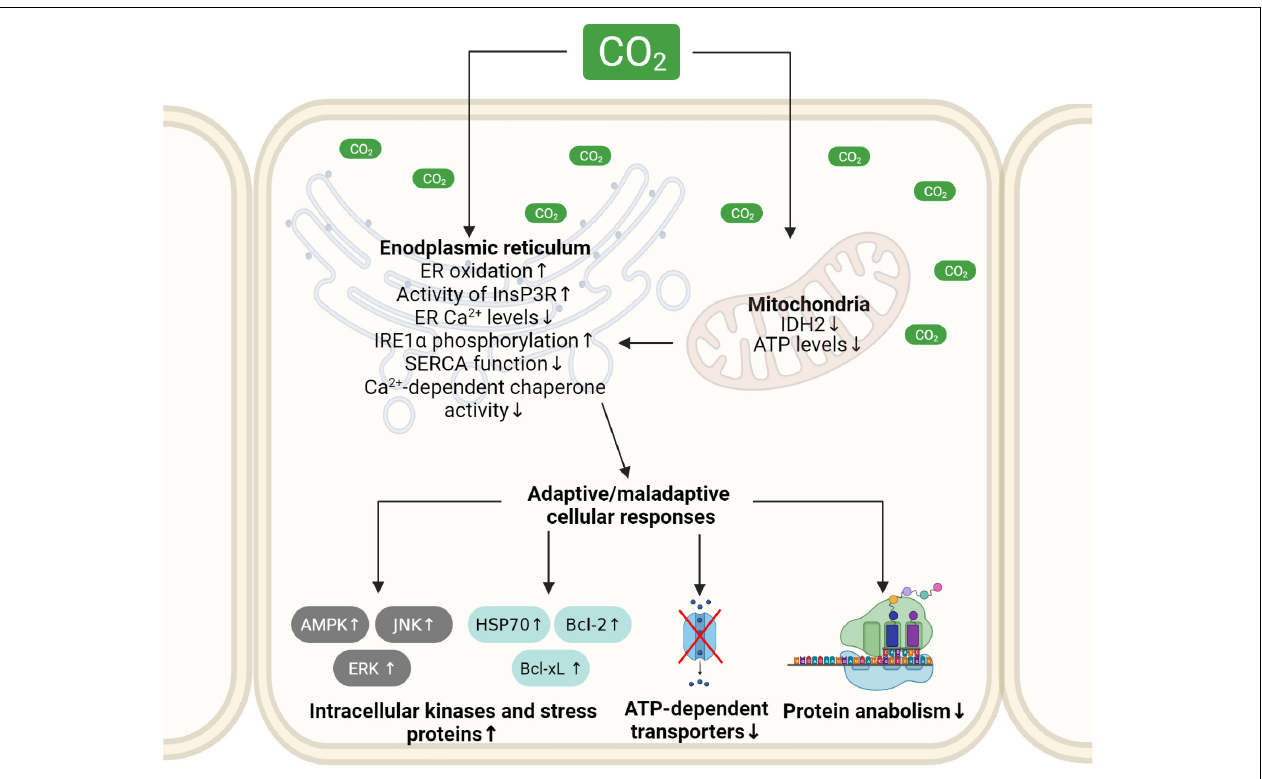
FIGURE 3 | Schematic depiction of molecular mechanisms driving hypercapnia-induced ER dysfunction and subsequent adaptive and maladaptive cellular responses. Elevated CO 2 levels reduce cellular ATP production, impair the oxidizing environment and alter calcium levels in the ER. These alterations in ER homeostasis cause ER stress and initiate adaptive and maladaptive cellular responses. ER, endoplasmic reticulum; IDH2, isocitrate dehydrogenase 2; InsP3R, ER membrane-localized inositol trisphosphate receptor; JNK, c-Jun N-terminal kinase; ERK1, extracellular signal-regulated kinase; AMPK, AMP-activated protein kinase; Bcl2, B-cell lymphoma 2 protein; Bcl-xL, B-cell lymphoma-extra large protein; HSP70, heat shock protein 70. Created with